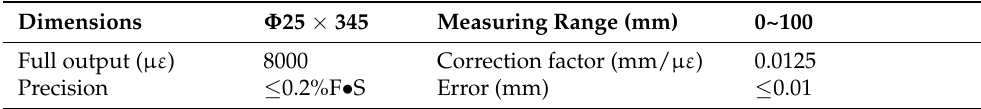
Table 1. Technical parameters of DMWY-100 surface type displacement meter.